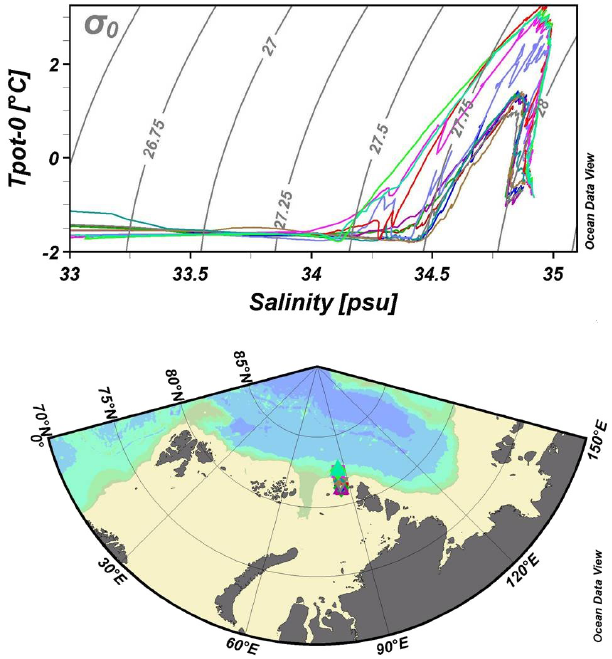
Fig. 4 . θS curves from the shelf and slope in the eastern Kara Sea showing the colder, less saline Barents Sea branch on the shelf and the warmer, more saline Fram Strait branch on the slope. The win- ter mixed layers are located above the thermocline, and here the Barents Sea branch is more saline than the Fram Strait branch.